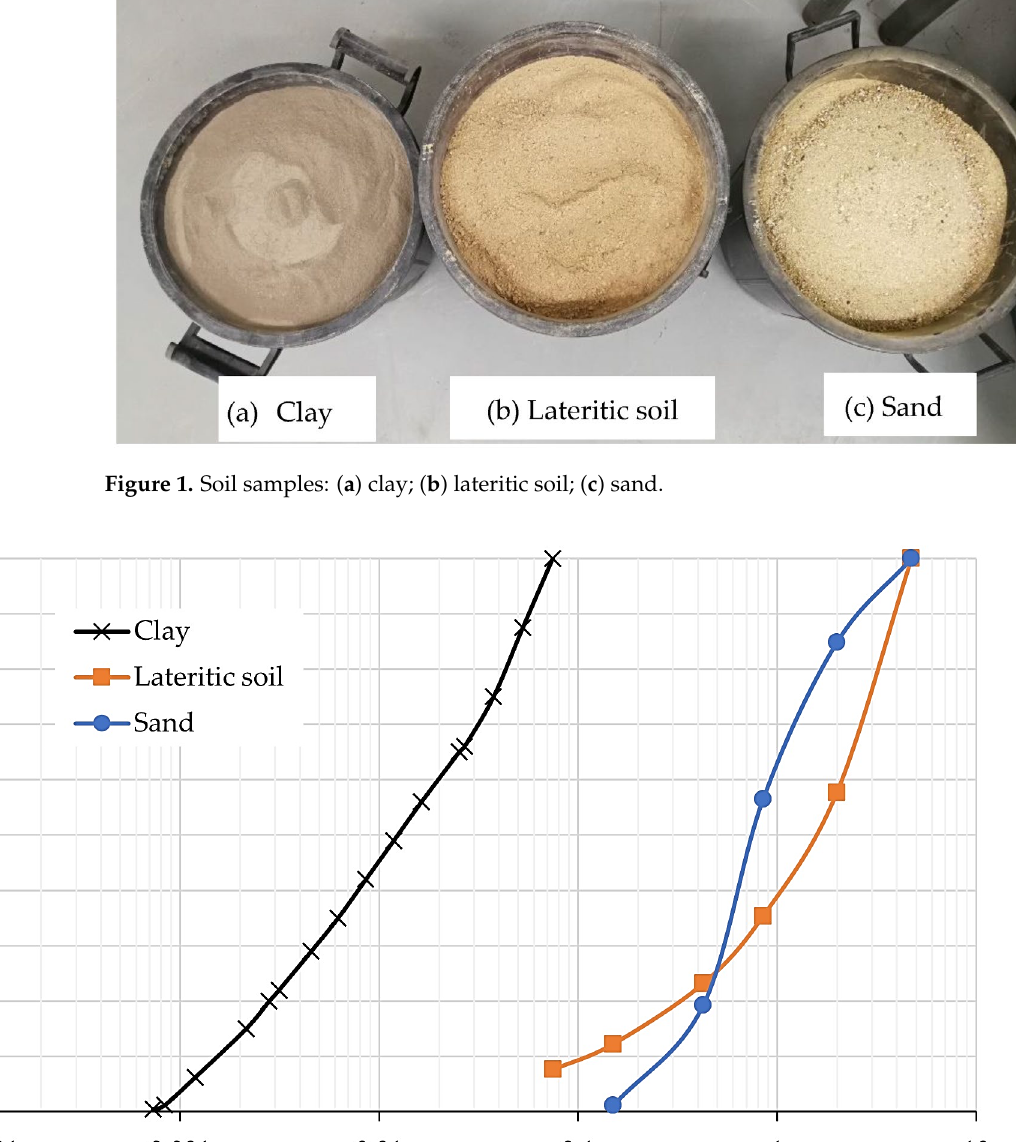
Figure 2. The particle size distribution of clay, lateritic soil, and sand .